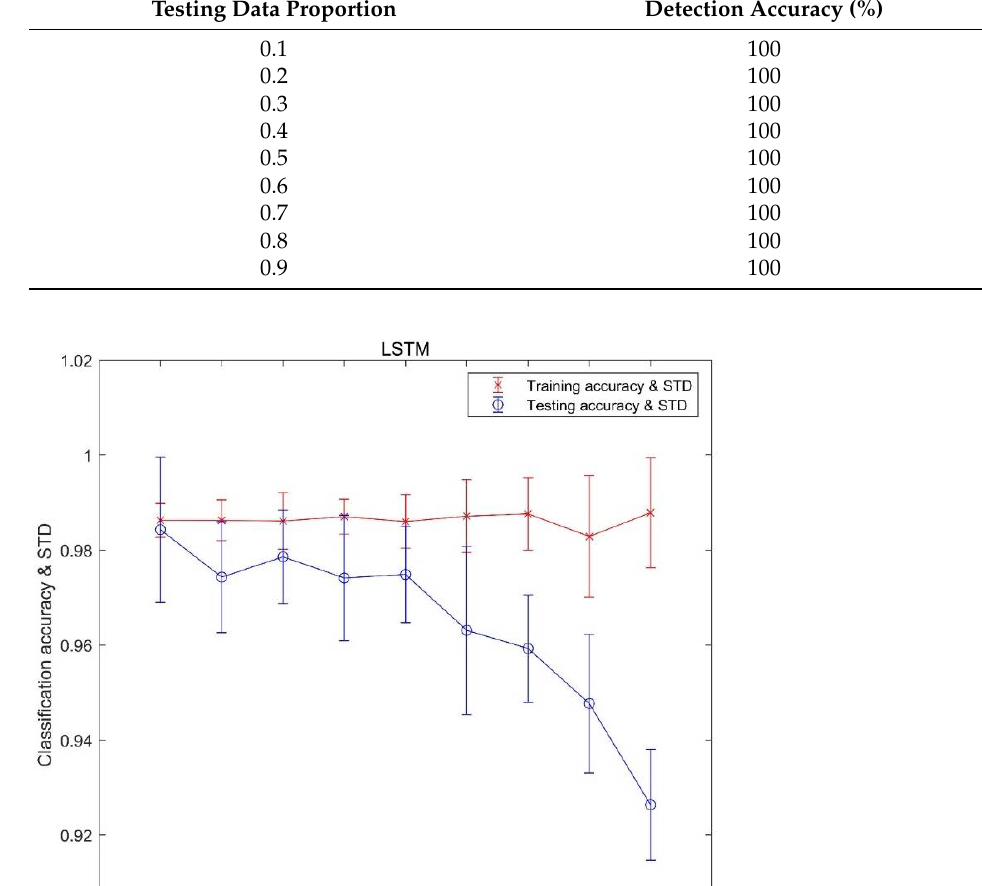
Table 5. Sample confusion matrix of the classification results.